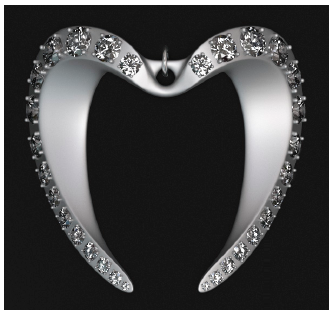
Figure 10. The tested complex surface model: jewelry.